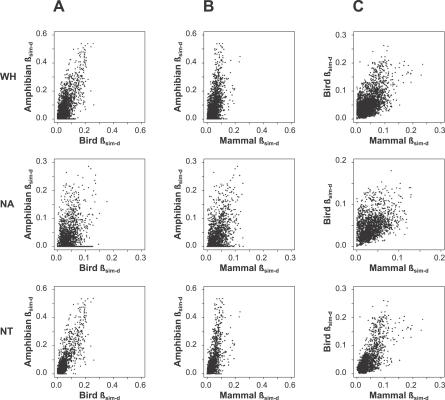
Cross-Taxon Relationships in Beta-Diversity of Amphibians, Birds, and MammalsScatter plots show the relationships between βsim-d for each pair of taxa within the Western Hemisphere (WH, top row), the Nearctic realm (NA, middle row), and the Neotropical realm (NT, bottom row). The axes for each plot are scaled according to the maximum βsim-d value of the two taxa within the extent specified. Note that maximum values are much greater for amphibians than for either birds or mammals and that all three taxa reach higher rates of assemblage change in the Neotropics than in the Nearctic. (A) Amphibians and birds. (B) Amphibians and mammals. (C) Birds and mammals.